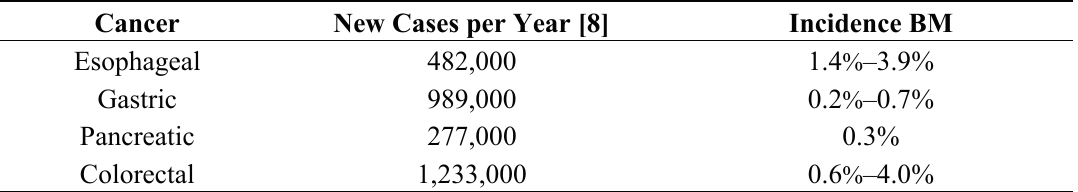
Table 1. Incidence of brain metastases in gastrointestinal